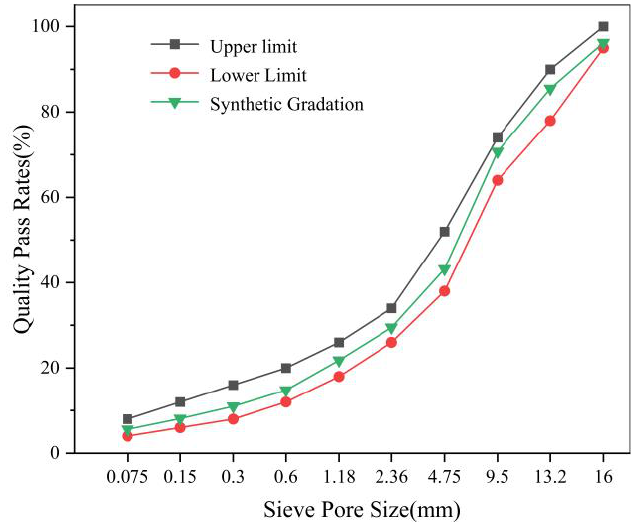
Figure 2. AC-16 asphalt mixture gradation design.